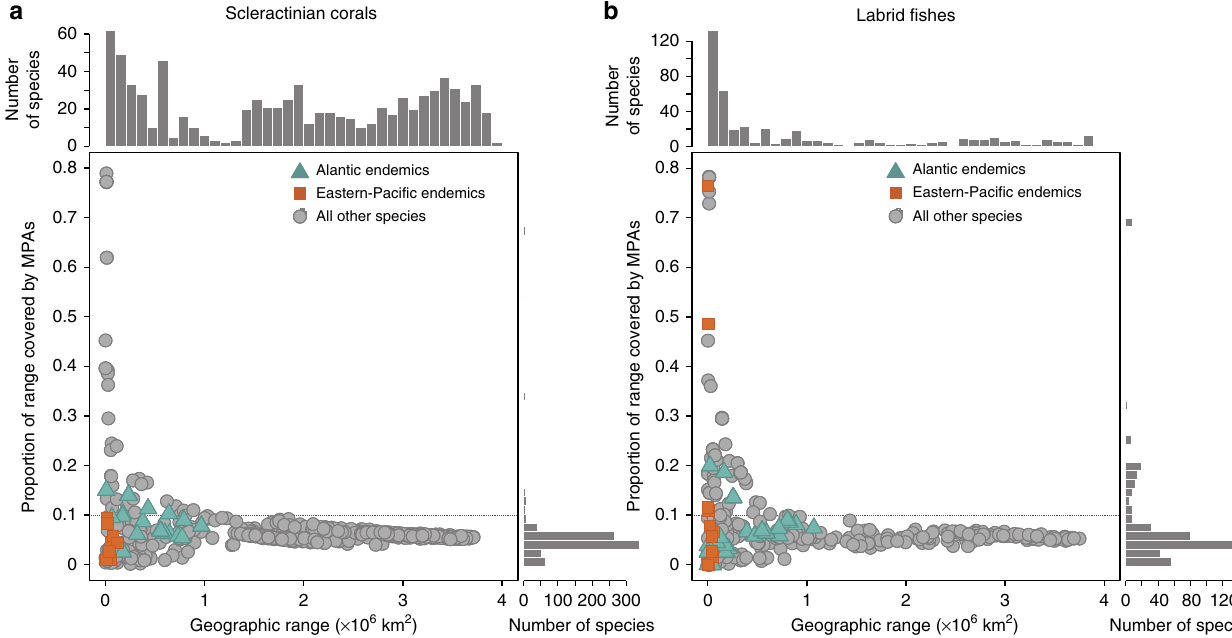
Figure 1 | Relationship between the total geographic range of species and the proportion of that range covered by the global system of MPAs. ( a ) Scleractinian coral species and ( b ) fish species of the family Labridae. Histograms on top and to the right represent the distributions of total ranges and proportion of protection among species respectively. Coloured squares and triangles represent endemic species, that is, only present in one of the two biogeographic realms: Atlantic and Eastern Pacific, respectively. Dotted lines represent the 10% threshold corresponding to the minimum representation target for sustaining species